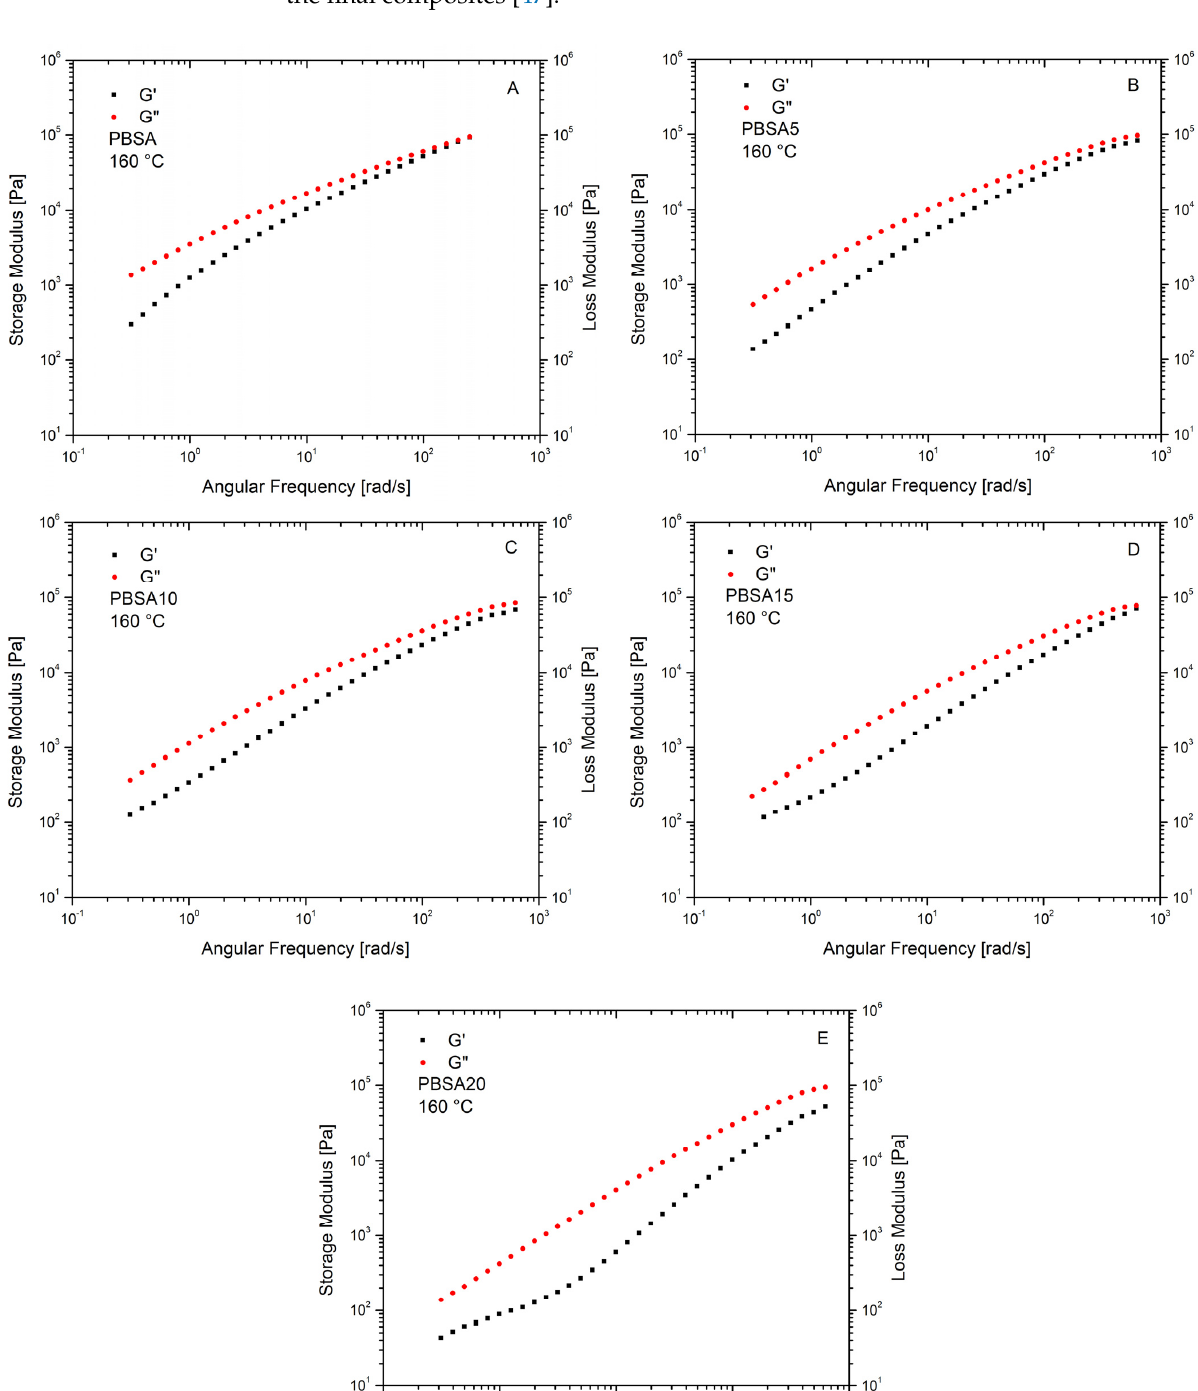
Figure 5. Complex viscosity versus angular frequency of PBSA and PBSA/BC composites at 160 °C ( A ) and 170 °C ( B ).